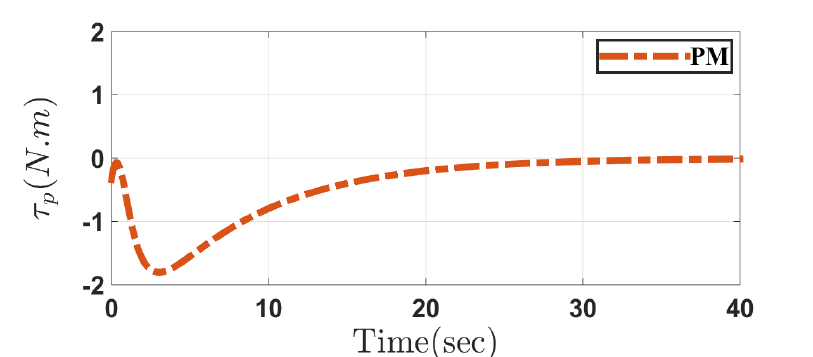
Figure 19. Input torque of the movable mechanism in the proposed method (PM) in Case 2.